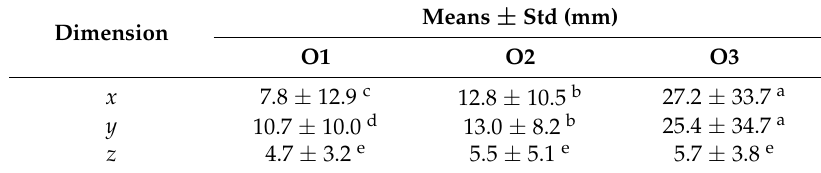
Table 4. Results of ANOVA test on the means of errors in three dimensions and each type of object. Means ± Std (mm) Dimension